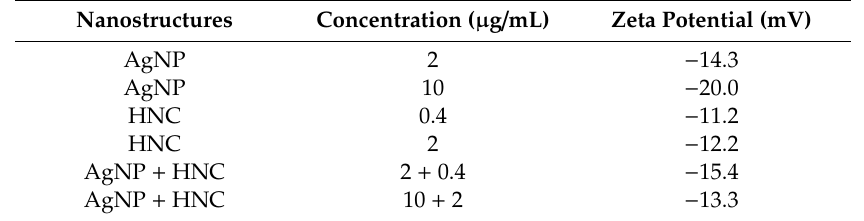
Table 1. The results of measuring the zeta potential of suspensions: of silver nanoparticles (AgNP), carbon nanostructures (HNC) and the mixture of silver nanoparticles and carbon nanostructure (AgNP + HNC). Nanostructures Concentration ( µ g / mL) Zeta Potential (mV) AgNP